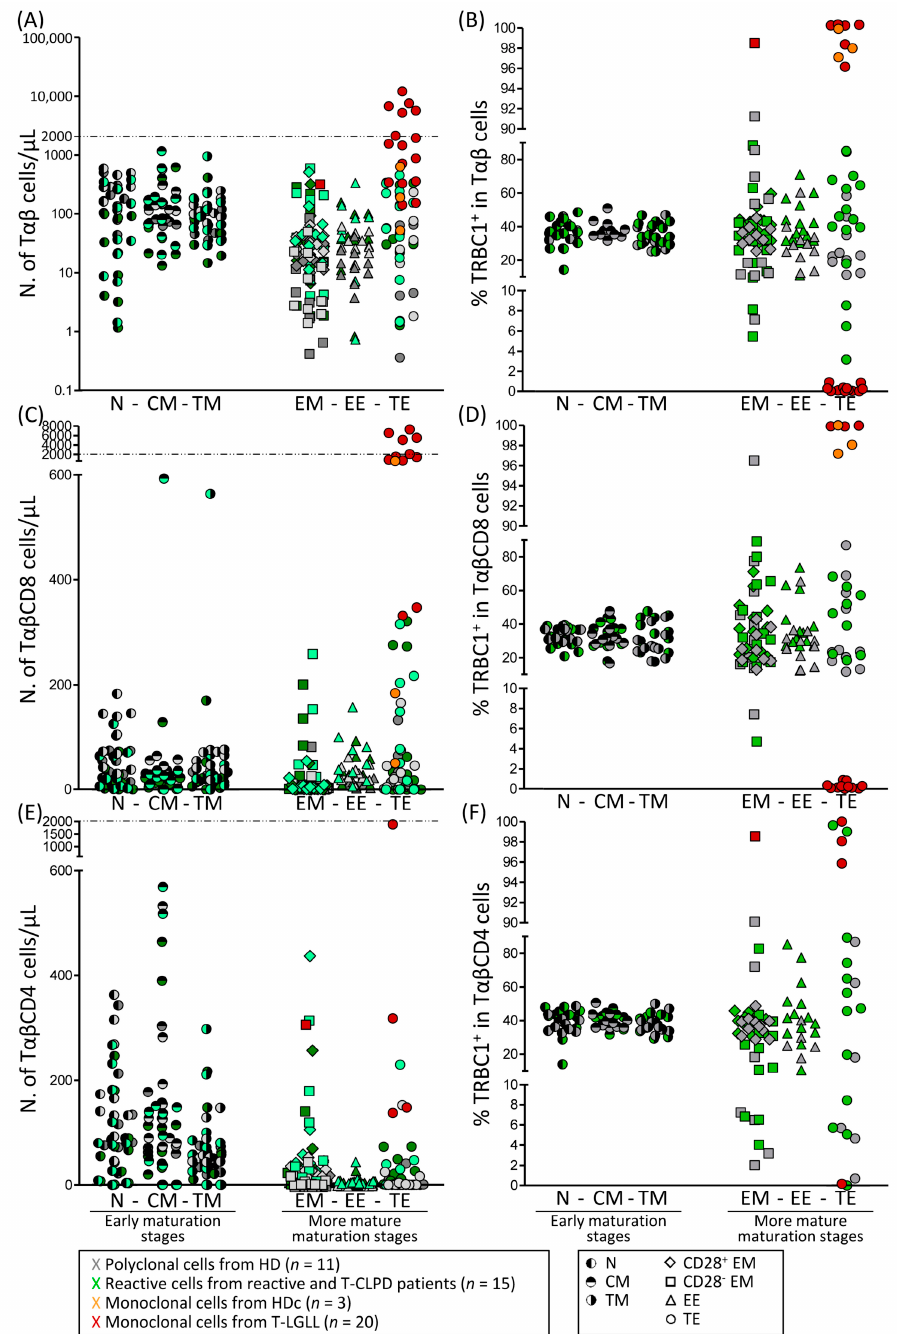
Figure 1. Absolute counts and relative distribution of TRBC1 + and TRBC1 − cells among normal/reactive (polyclonal) T αβ -cell populations from normal/reactive blood classified according to their maturation stage vs. clonal T αβ -LGL. Absolute ( A , C , E ) and relative ( B , D , F ) number of TRBC1 + (dark color) and TRBC1 − (light color) cells identified among normal (gray dots) and reactive (green dots) populations of (polyclonal) total T αβ cells ( A , B ), T αβ CD8 cells ( C , D ) and T αβ CD4 cells ( E , F ), classified according to their maturation stage, compared to clonal T αβ -LGL from HDc (orange dots) and T-LGLL (brown dots). Abbreviations (alphabetical order): CM, central memory; EE, early effector; EM, effector memory; HD, healthy donor; HDc, healthy donor with a T αβ clone; LGL, large granular lymphocyte; N, naïve; N., number; PB, peripheral blood; T-CLPD, chronic lymphoproliferative disorder of T cells; T-LGLL, T-cell large granular lymphocytic leukemia; TE, terminal effector; TM, transitional memory.